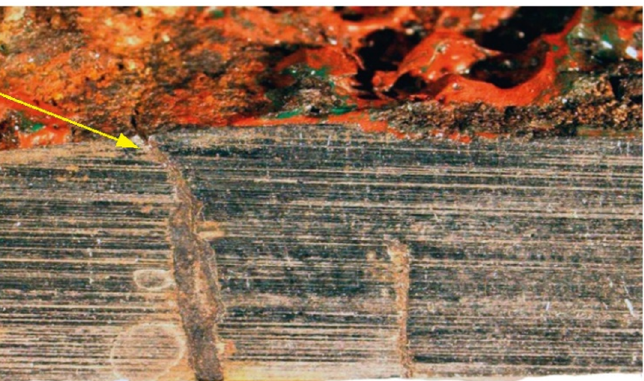
Figure 22. The passage of the crack from part II into part I through the weld that joins the two parts (handy-size bulk carrier 30206 DWT). Macroscopic examination.